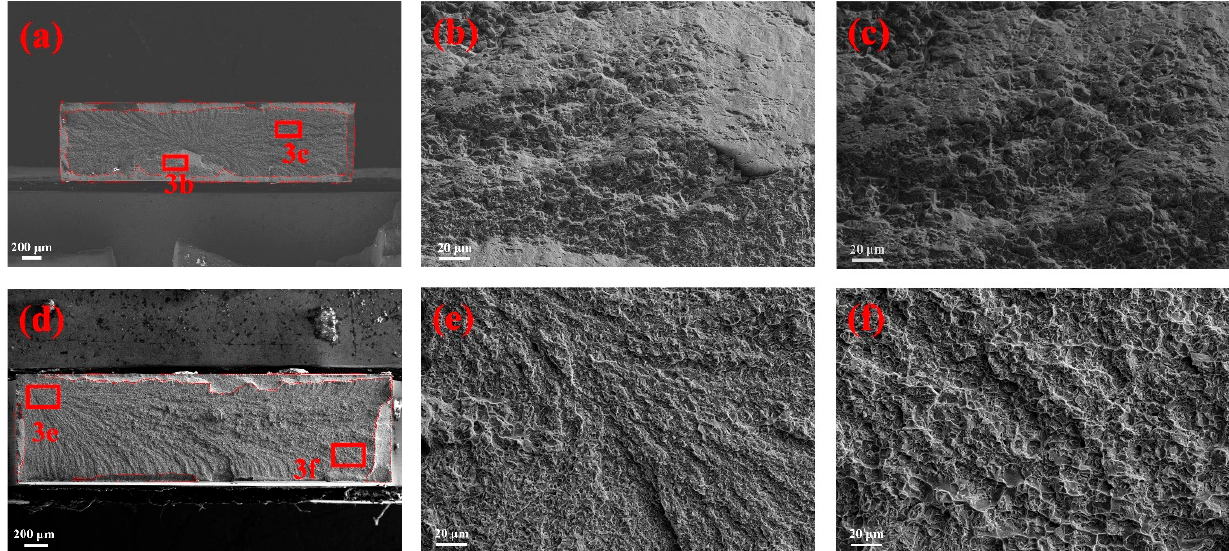
Figure 3. Fracture morphology of Al 0.5 Cr 0.9 FeNi 2.5 V 0.2 tested at room temperature with and without hydrogen charging: ( a ) uncharged and ( b , c ) magnified regions of red frame in ( a ), respectively; ( d ) hydrogen-charged and ( e , f ) magnified regions of red frame in ( d ), respectively.